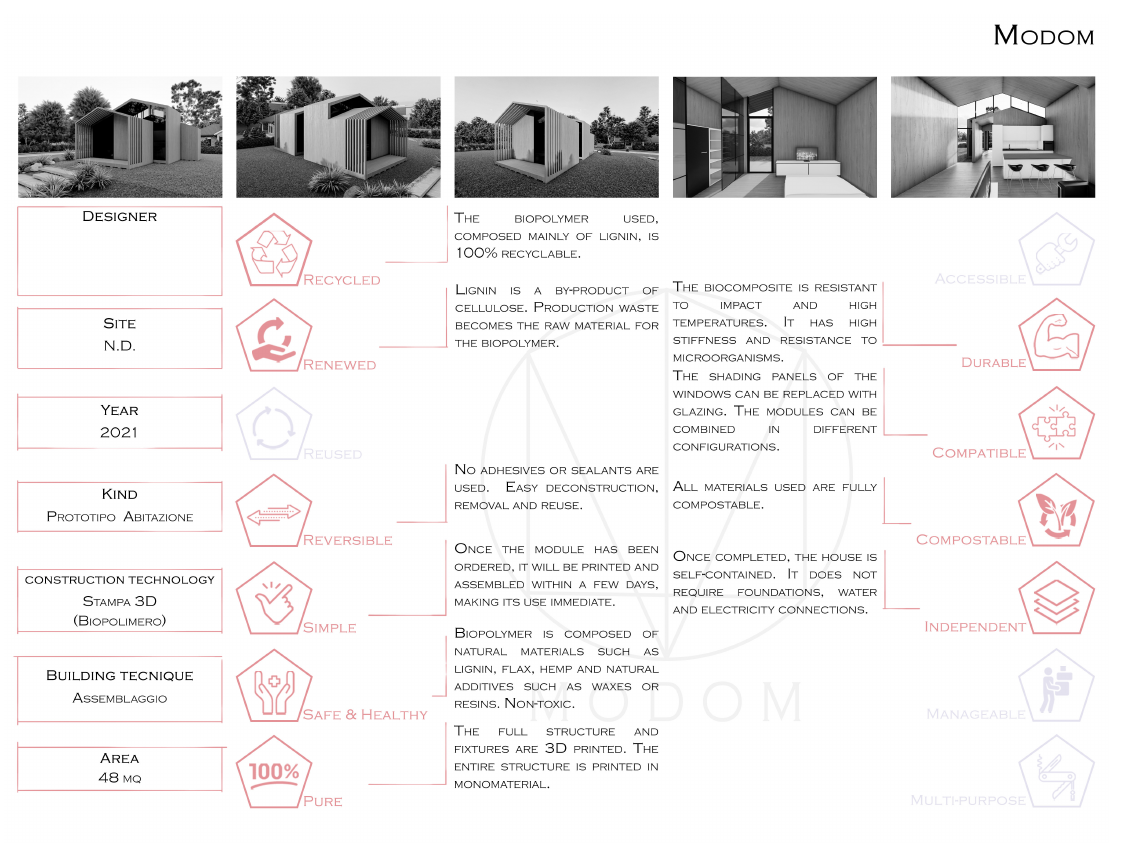
Figure 6. Critical analysis of the “MoDom” through Circular Design Qualities (VUB).